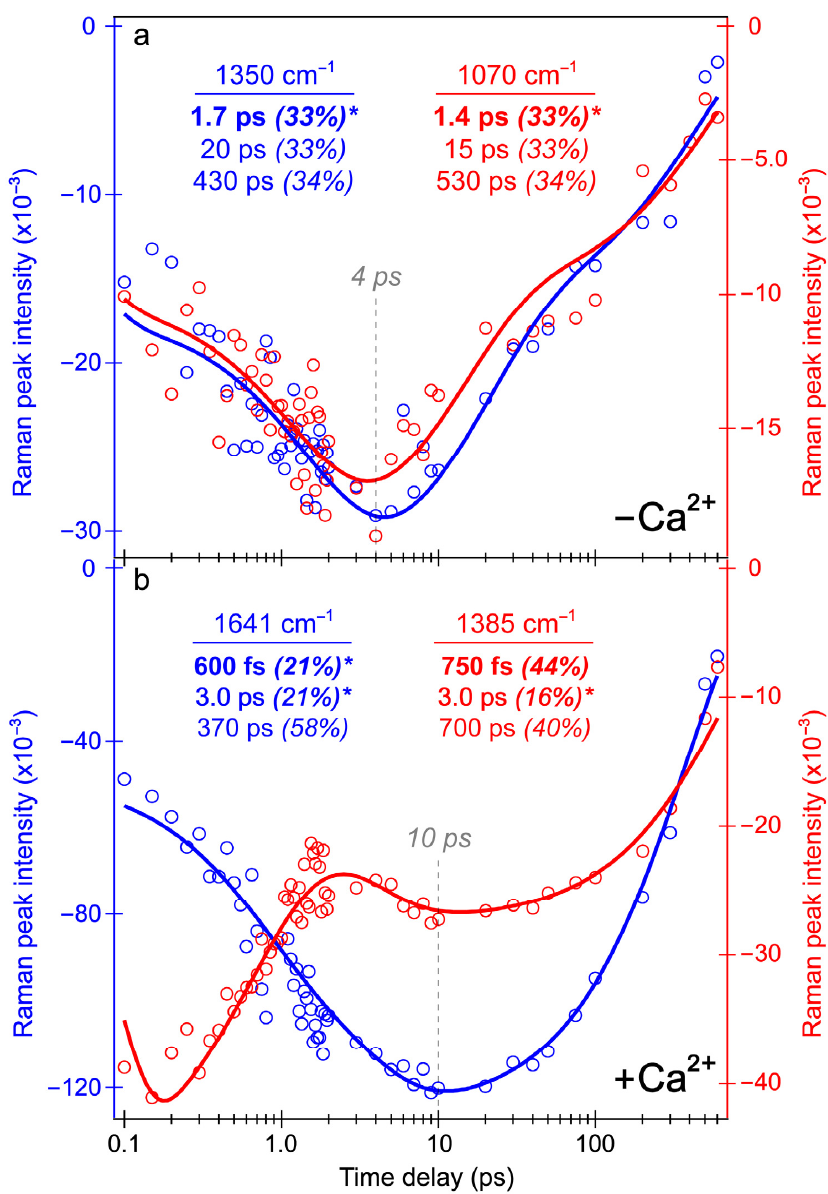
Figure 8. Integrated peak intensity dynamics from the REX-GECO1 biosensor’s excited-state FSRS spectra in pH 7 aqueous buffer. Intensity dynamics of the Raman bands centered at ( a ) 1350 cm − 1 (blue) and 1070 cm − 1 (red) of the Ca 2+ -free biosensor, and ( b ) 1641 cm − 1 (blue) and 1385 cm − 1 (red) of the Ca 2+ -bound biosensor. The data points (color-coded circles) are overlaid with the least-squares fits (solid curves) on a logarithmic timescale (horizontal axis). The retrieved time constants and amplitude weight percentages are listed accordingly, with the asterisks denoting the intensity rise components. Gray dashed lines highlight distinct delay times for the SE bands to reach maximal intensity magnitudes during the excited-state spectral evolution of the Ca 2+ -free (~4 ps in ( a )) and bound (~10 ps in ( b )) biosensors.